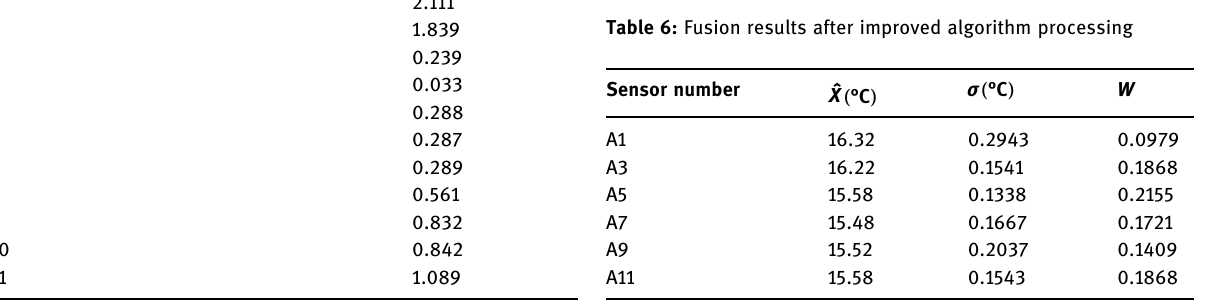
Table 3: Processing process of group A1 data by grubs method Frequency